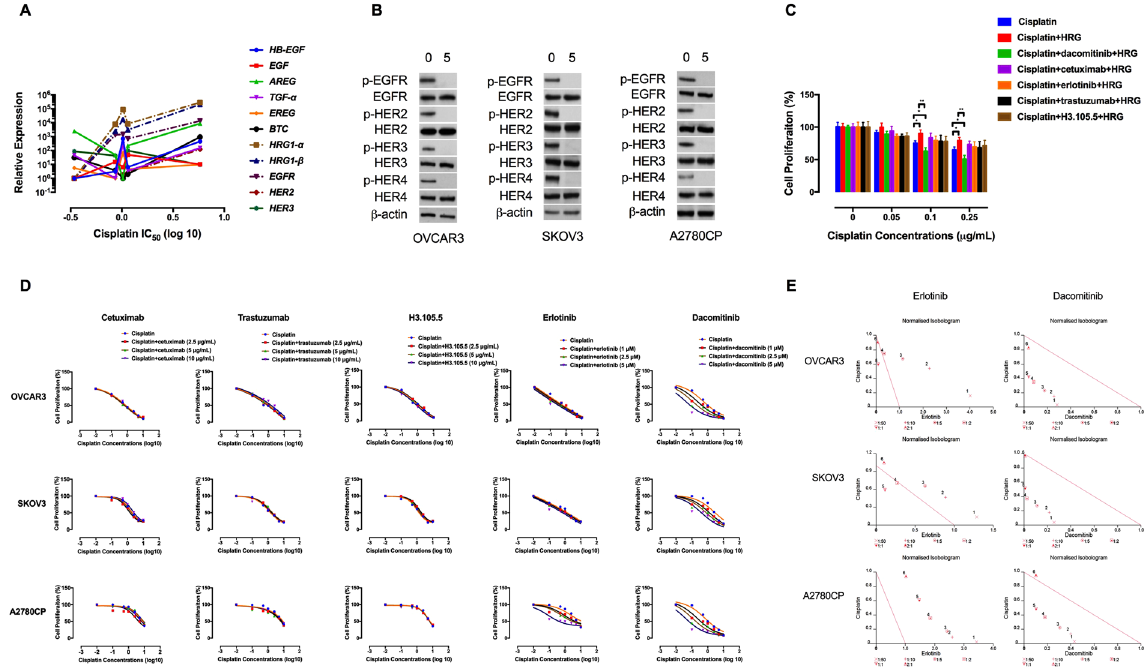
Figure 2. The ErbB family contributes to cisplatin resistance. ( A ) Correlation of expression of HRG1 - α , HRG1 - β , EGFR and HER2 with resistance to cisplatin. EOC cell lines with higher expression of HRG1 - α , HRG1 - β , EGFR and HER2 showed significantly higher cisplatin IC 50 values. The correlation coefficient (r) between the expression of EGFR and HER2 and cisplatin concentrations was 0.917 ( P = 0.0281) and 0.890 ( P = 0.0341), respectively. ( B ) Dacomitinib inhibits ErbB activation. The effect of dacomitinib (5 μ M) on ErbB activation was determined by Western blot analysis. Protein lysates were subjected to Western blotting and probed with the indicated antibodies. β -actin was used as the loading control. The blots are representative of three independent experiments with similar results. ( C ) The effects of the ErbB inhibitors on HRG β -1-induced proliferation in cisplatin-treated Caov4 cells were shown by MTT assay. The cells were pre-treated with the anti-ErbB agents for 4 h, followed by treatment with HRG β -1 for 48 h. ( D ) The effects of the ErbB inhibitors- cisplatin therapy on cell proliferation were investigated by MTT assay after 48 h of treatment and the data are shown by IC 50 shift analysis. The concentrations of cisplatin were 0.1, 0.5, 1, 2.5, 5 and 10 μ g/mL. ( E ) Normalised isobolograms of combination of erlotinib (5 μ M) and dacomitinib (5 μ M) with cisplatin. The data were analysed using the CalcuSyn software. The connecting line represents additivity. Data points located below the line indicate a synergistic drug-drug interaction and data points above the line indicate an antagonistic interaction. The numbers under the isobolograms indicate the concentrations of the drugs in combination. Data shown represent the mean ± SD from three independent experiments, each performed in triplicate. Statistically significant values of * p < 0.05 and ** p < 0.01 were determined compared with the